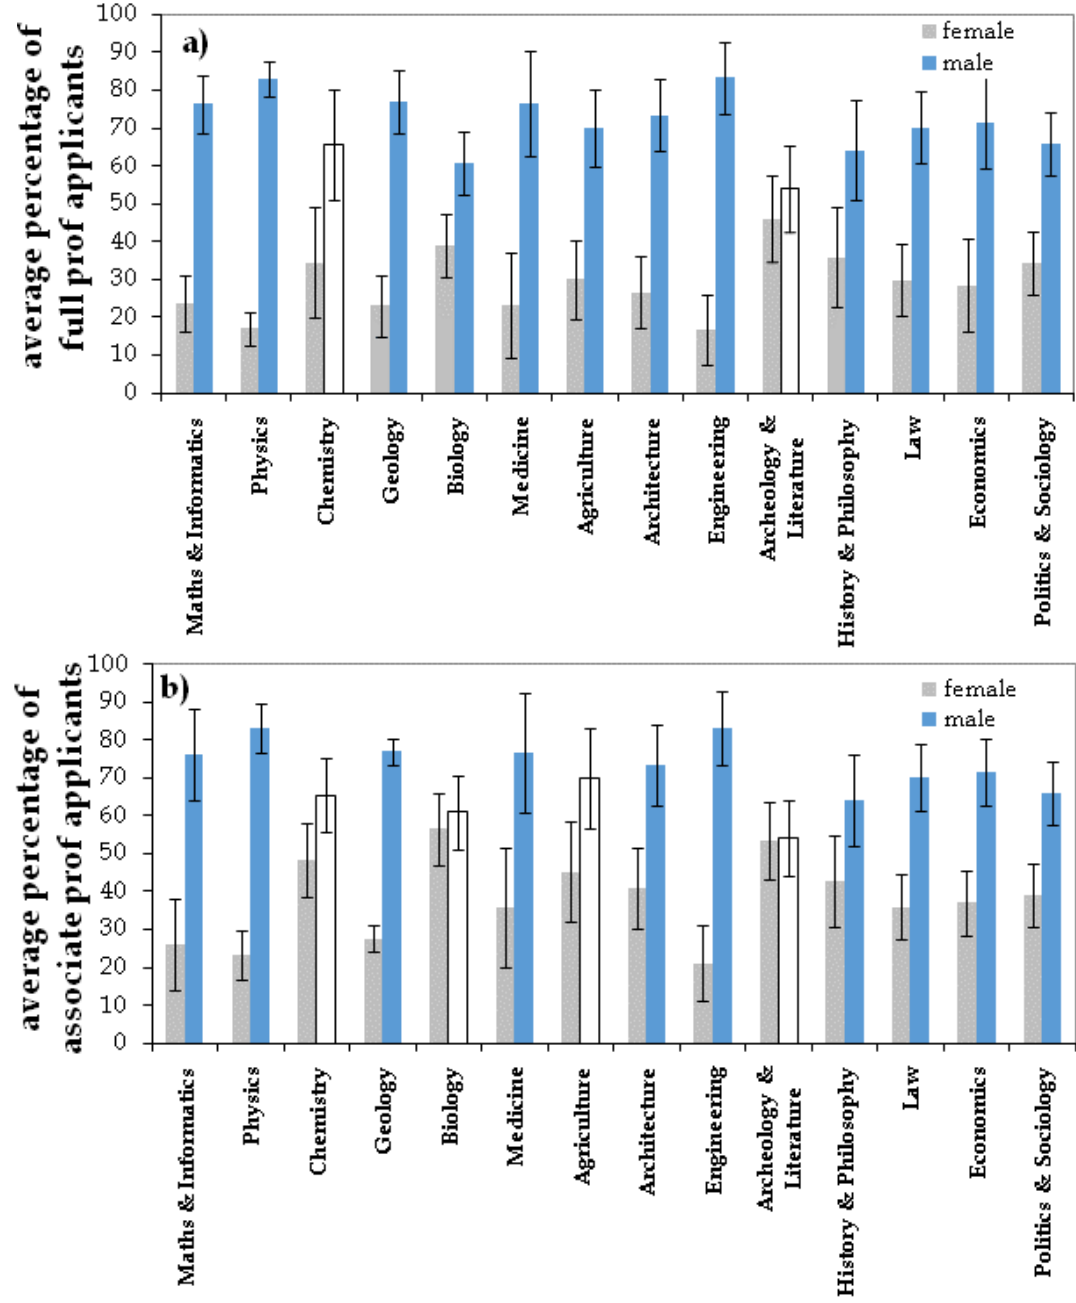
Figure 2. Frequency distribution in the 14 fields of the Italian national habilitation competition (2012) of the average percentage of female vs . male applications at the ( a ) full and ( b ) associate professor levels. Significant differences (paired t -test, all with p < 0.01, apart from history and philosophy with p = 0.049) are shown in color. The only non-significant differences are in panel ( a ) for chemistry ( p = 0.06), and archeology and literature ( p = 0.16), and in panel ( b ) for chemistry ( p = 0.81), biology ( p = 0.08), agriculture ( p = 0.64), and archeology and literature ( p = 0.14). Error bars show standard